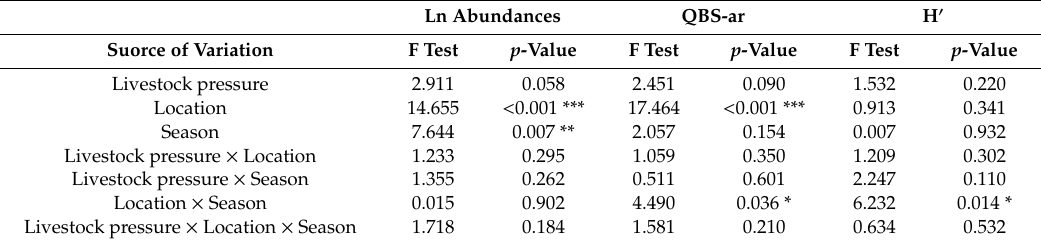
Table 2. Three-way ANOVA on log-transformed abundances, QBS-ar and Shannon’s index (H (cid:48) ). Asterisks indicate levels of significance (*) = p < 0.05; (**) = p < 0.01; (***) = p < 0.001. “Location” indicates whether the sampling point was located beneath tree canopies (in-C) and outside the canopy